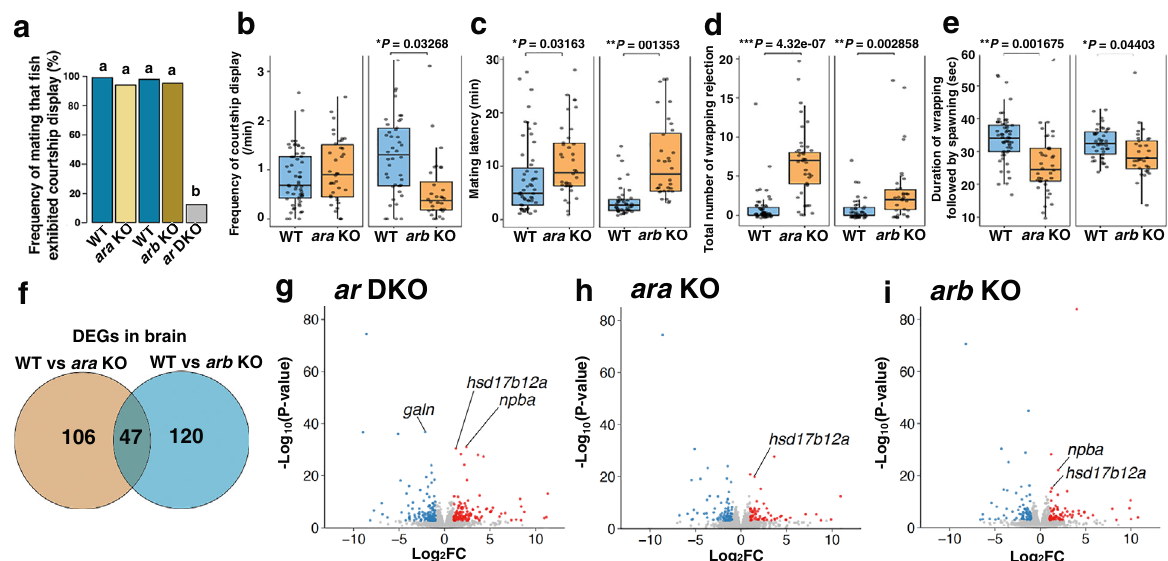
Fig. 5 | Both ara and arb are required for high male reproductive success. a Percentage of mating tests with different females in which a male exhibited courtshipdisplaywithina30mintestperiod.WeusedWT( n =11,total59matings) and ara KOmales( n =14,total76matings)ofthesamelitter,andWT( n =6,total40 matings) and arb KO males ( n =6, total 40 matings) of the same litter, and ar DKO males ( n =10, total 43 matings) as mating partners for the WT females. The blue, lightbrown,darkbrown,andgreycoloursindicateWT, ara KO, arb KO,and ar DKO, respectively. Means are shown. Different letters above the boxes indicate sig- ni fi cantly different groups ( P <0.05, two-sided f isher ’ s exacttest with a Bonferroni correction). b Frequency of courtship displays before spawning. c Time required for spawning (mating latency). d Total number of wrapping rejections by female. e Duration of wrapping followed by spawning. For b to e , we used WT ( n =11, total 55 mating) and ara KO males ( n =13, total 38 matings) of the same litter and WT ( n =6,total42matings)and arb KOmales( n =6,total32matings)ofthesamelitter. The blue and brown colours in panel b to e indicate WT and ar KO males,